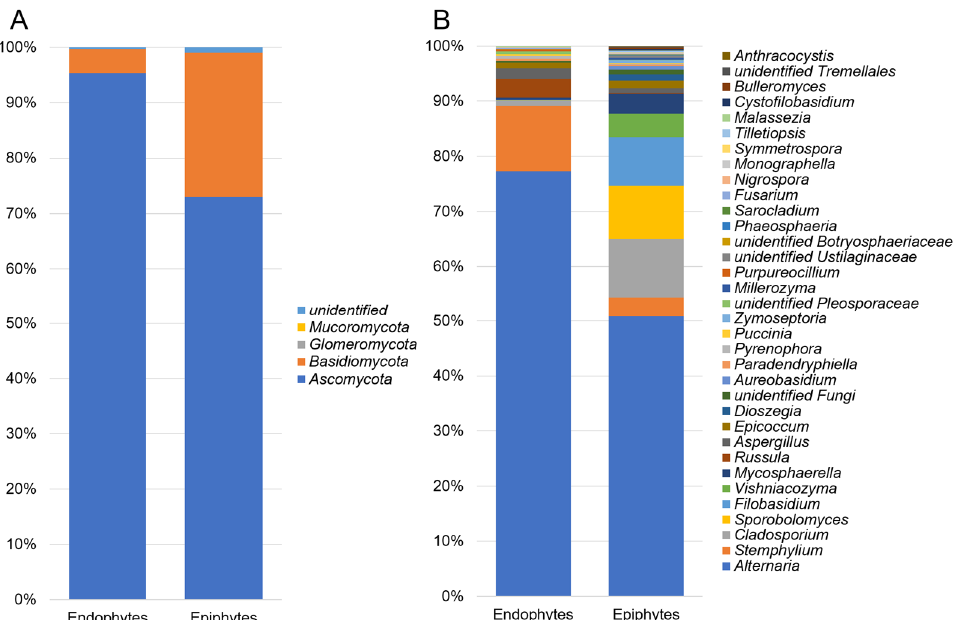
Figure 2. Relative abundance of fungal phyla ( A ) and genera ( B ) among endophytes and epiphytes detected in grain samples using high-throughput sequencing technology.